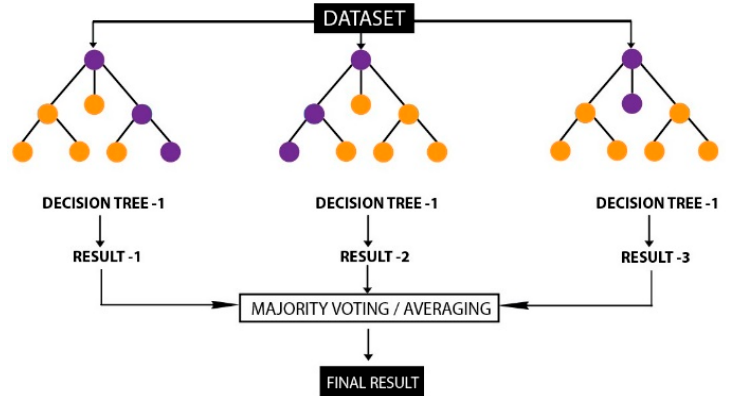
Figure 1. Random Forest Structure.